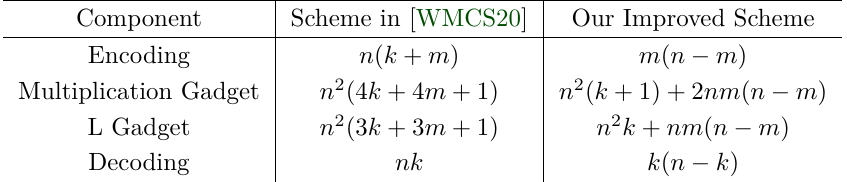
Table 1: Comparison of the number of field multiplications in different